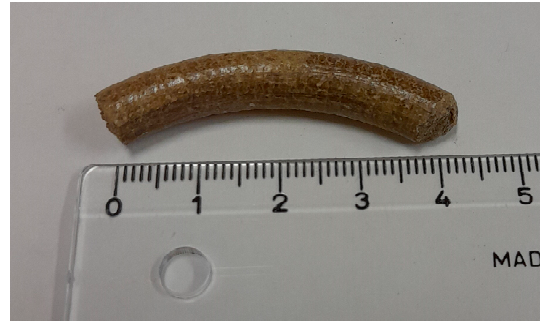
Figure 6. Dimension of a random pellet.